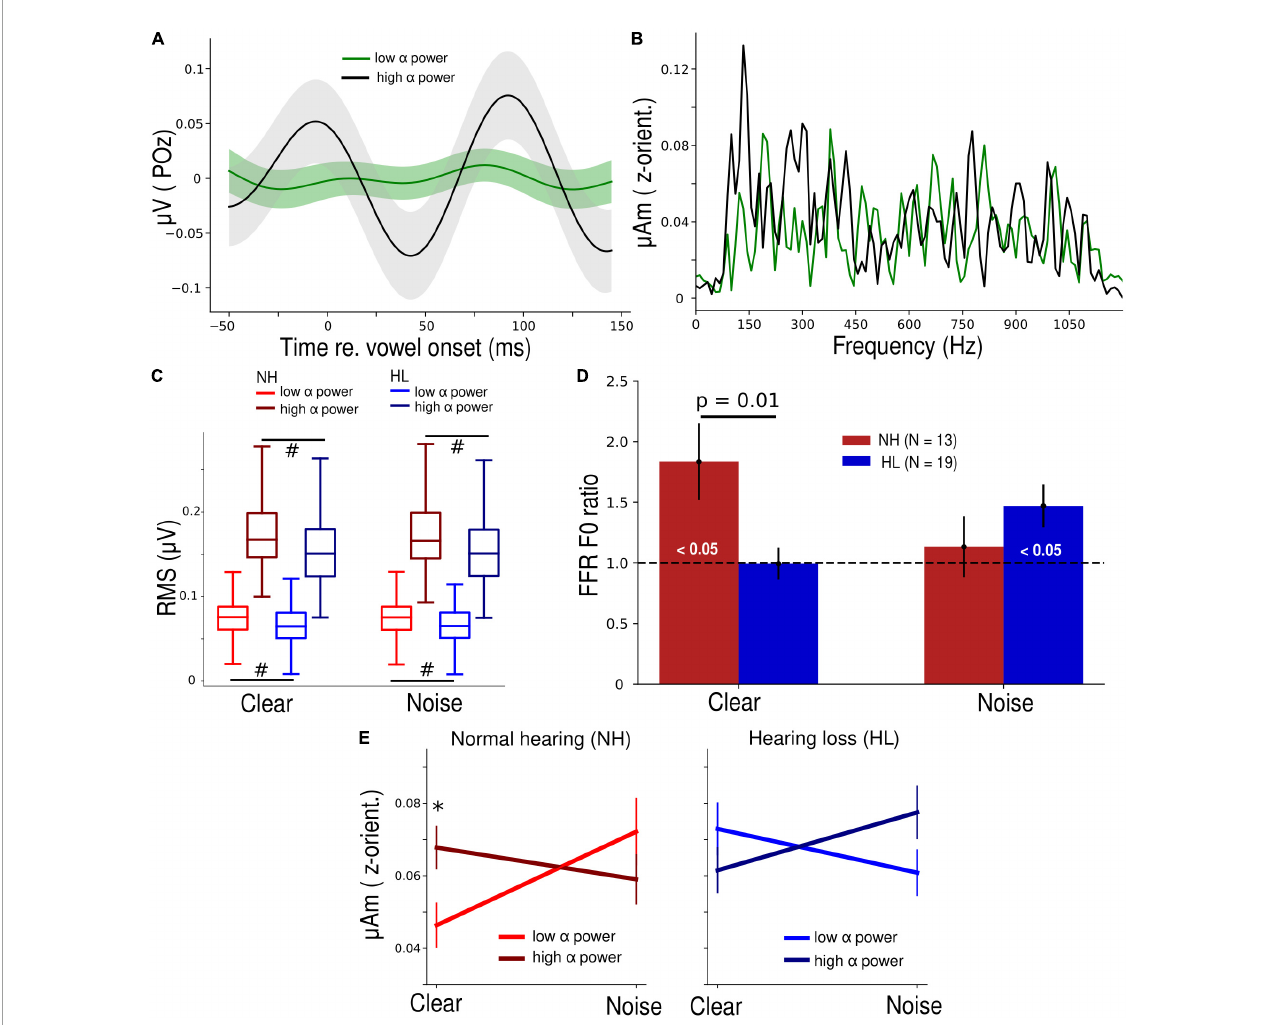
FIGURE2 Normal hearing (NH) participants have a higher parieto-occipital α power and their brainstem speech processing is more strongly modulated by α band in clear backgrounds. (A) Average α waveform of low- and high-power trials plotted from a representative NH participant. (B) Frequency spectra of the steady state (10–100 ms) portion of low and high α brainstem FFRs from the same participant panel (A) . Note the distinct response at ∼ 150 Hz, corresponding to the voice pitch. (C) Root-mean-square (RMS) values of both low and high α of the NH group were significantly higher than the HL group. # p < 0.01 (Conover’s test, non-parametric pairwise test, with Bonferroni adjustment). (D) FFR F0 ratios during low and high α trials. FFR F0 ratios were higher in the NH vs. HL group (Mann-Whitney U test) in the clear condition. Bars marked ( < 0.05) are significantly larger than 1 (1-sample t -test) indicating enhancement of the FFR with changes in cortical α . (E) Grand average FFR F0 amplitudes as a function of SNR (clear vs. noise), α power (low vs. high), and group (NH vs. HL). Error bars = ± s.e.m., ∗ p < 0.05 (Wilcoxon signed-rank